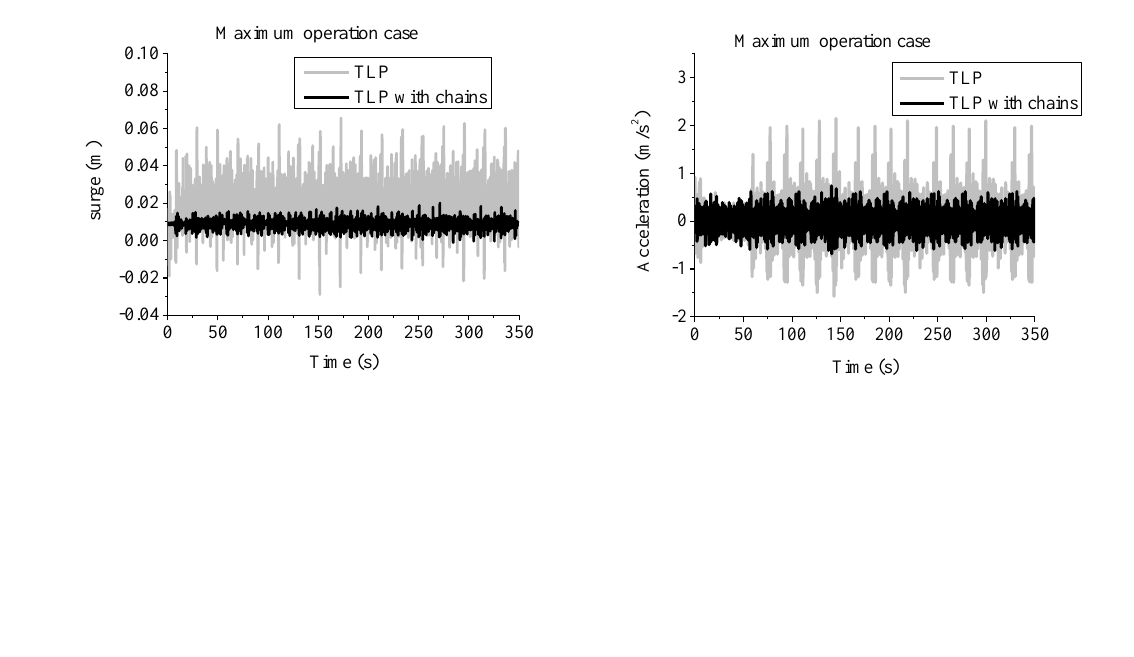
Figure 9. The comparison of the two FOWT’s main dynamic responses under maximum operation case. ( a ) Surge displacement ( top left ); ( b ) Surge acceleration ( top right ); ( c ) Typical tension leg force ( bottom